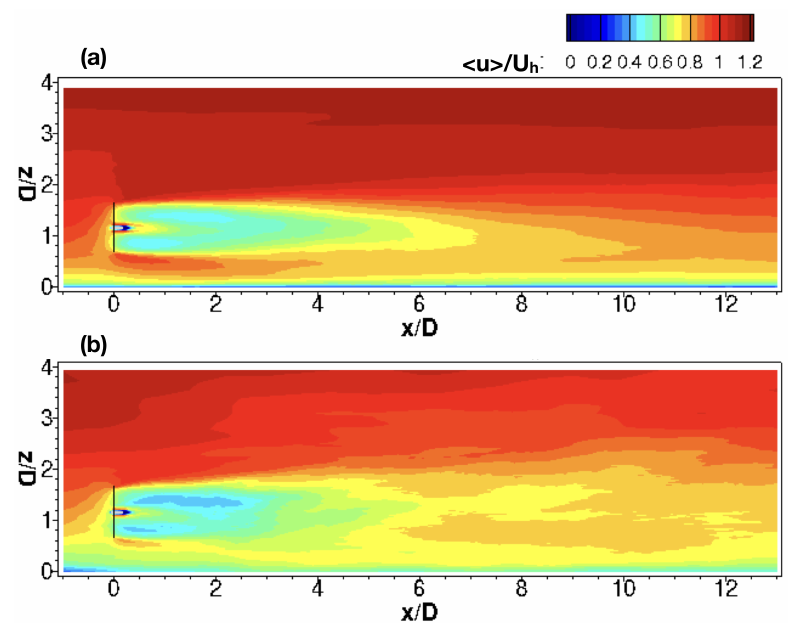
Figure 6. Time-averaged downwind velocity on the x-z plane passing through the rotor center for ( a ) T80 and ( b ) T27, respectively.